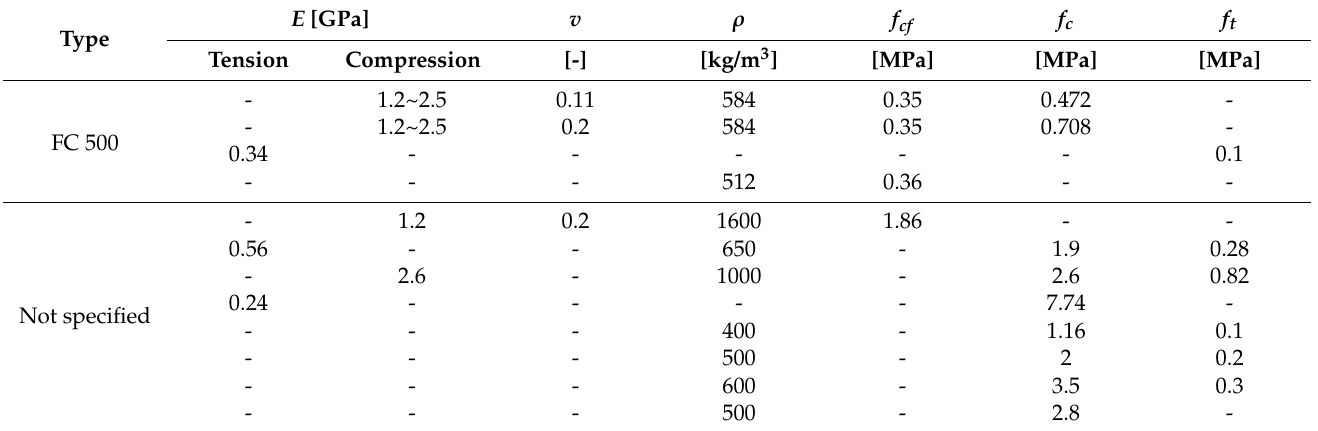
Table 1. Selected material characteristics of foam